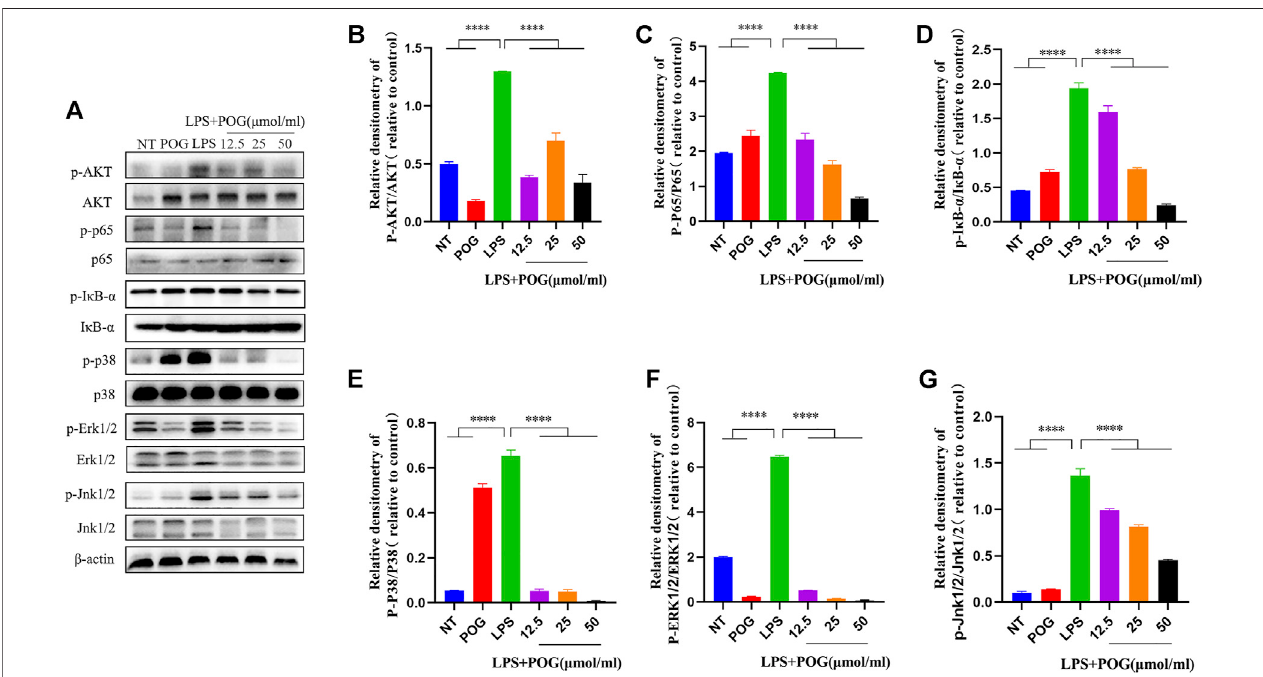
FIGURE 9 | POG treatment inhibits MAPK, NF- κ B, and AKT pathway activation within LPS-treated RAW264.7 cells. (A) Protein phosphorylation of MAPK-, AKT-, and NF- κ B-related pathways was assessed by Western Blot. (B – G) Express MAPK, AKT, and NF- κ B signal pathway phosphorylated protein levels and calculate the corresponding phosphorylated protein ratio. Data are means ± SD ( n = 3). *p < 0.05, **p < 0.01, ***p < 0.001, ****p <